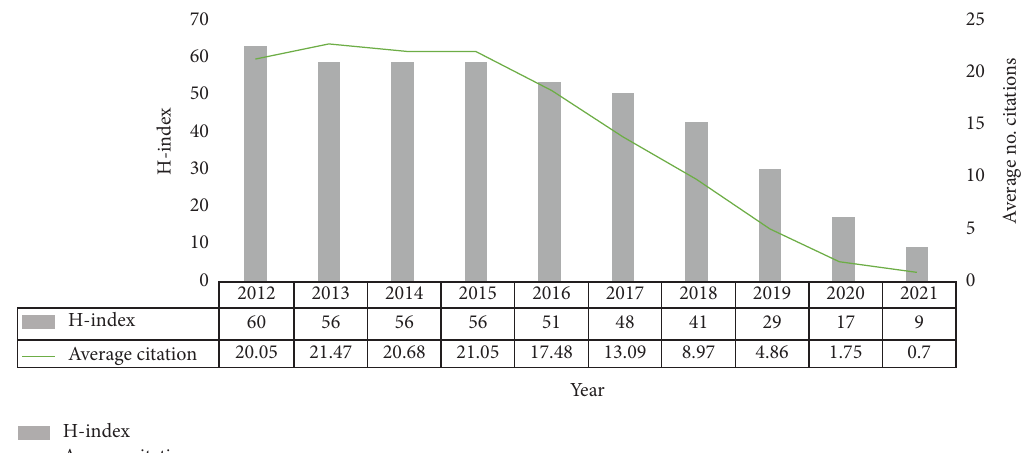
Figure 5: Average citations to publications about acute postsurgical pain and H-index of such publications by year, 2012–2021. Notes: the data has been taken from the publication year to the retrieved date (February 10, 2022); H-index: the H-index for the corresponding year was defned as all publications in the APSP feld during this period in which at least H papers were cited at least H times.